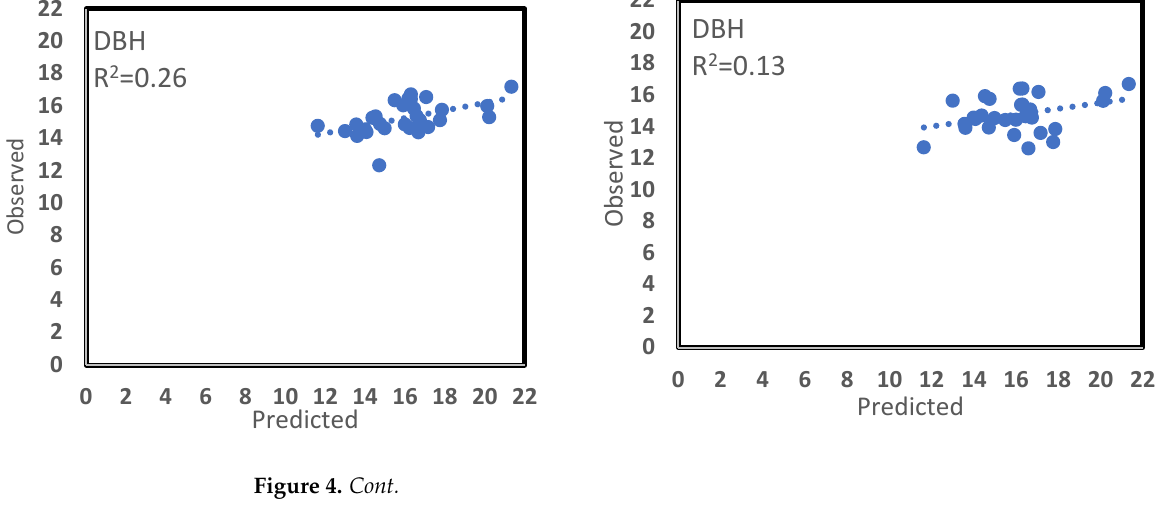
Figure 3. Relationships between observed and predicted values based on the independent test da ‐ taset of the 2nd cycle measurement: multiple linear regression models on left column and random forests models on the right column.